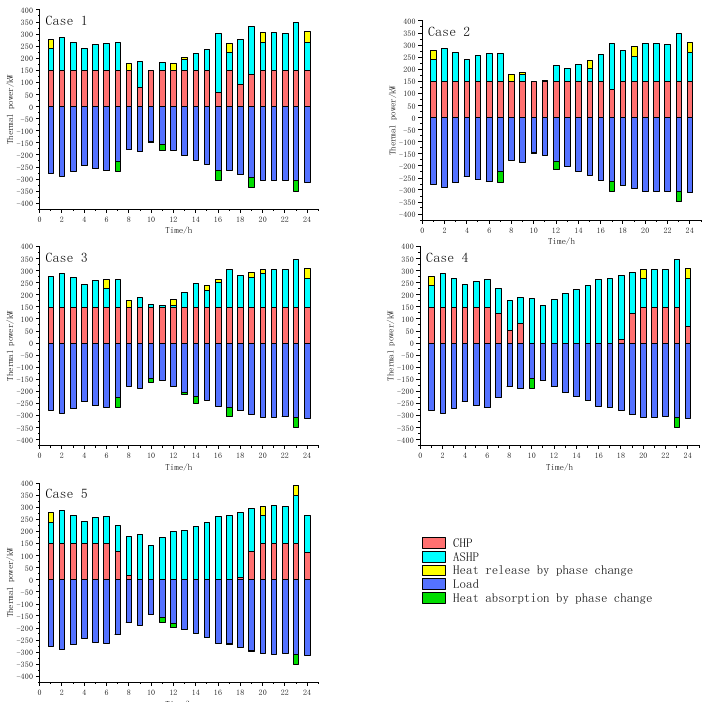
Figure 8. The optimal dispatch result of thermal power in five cases.